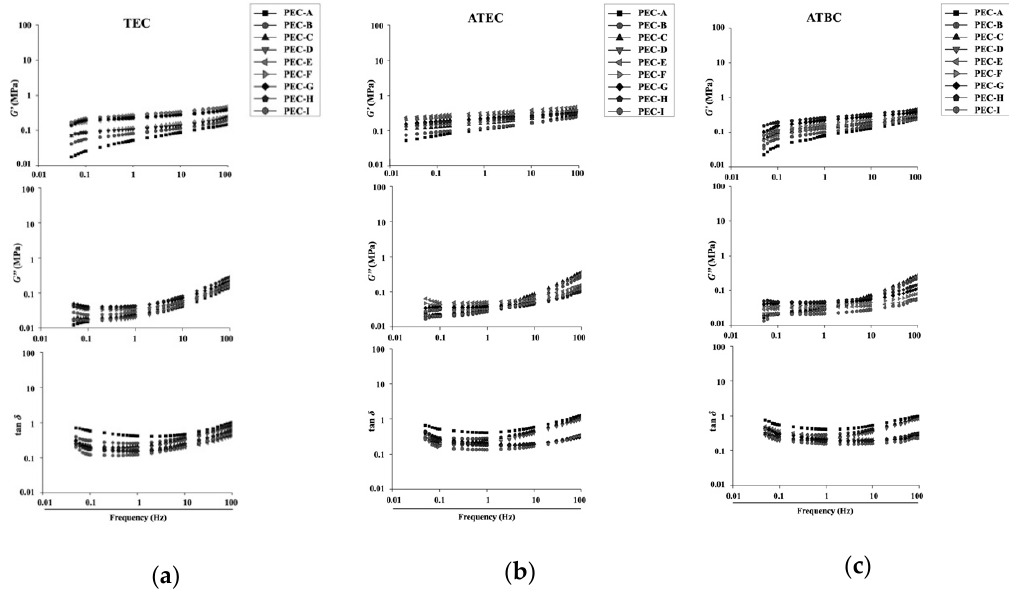
Figure 7 . Variation of the storage modulus ( G ′ ), loss modulus ( G ″ ), and loss tangent (tan δ ) with frequency for each group before immersion: ( a ) Triethyl Citrate (TEC) group; ( b ) Acetyl Triethyl Citrate (ATEC) group; and ( c ) Acetyl Tributyl Citrate (ATBC) group.